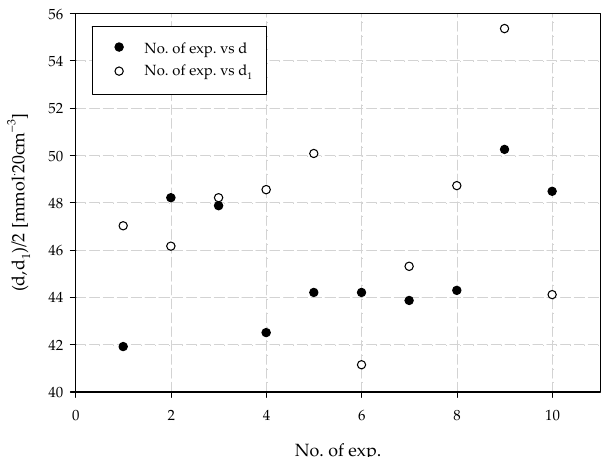
Figure 16. d with and without dosing of AAB to B10. Comparison of the mean d and d